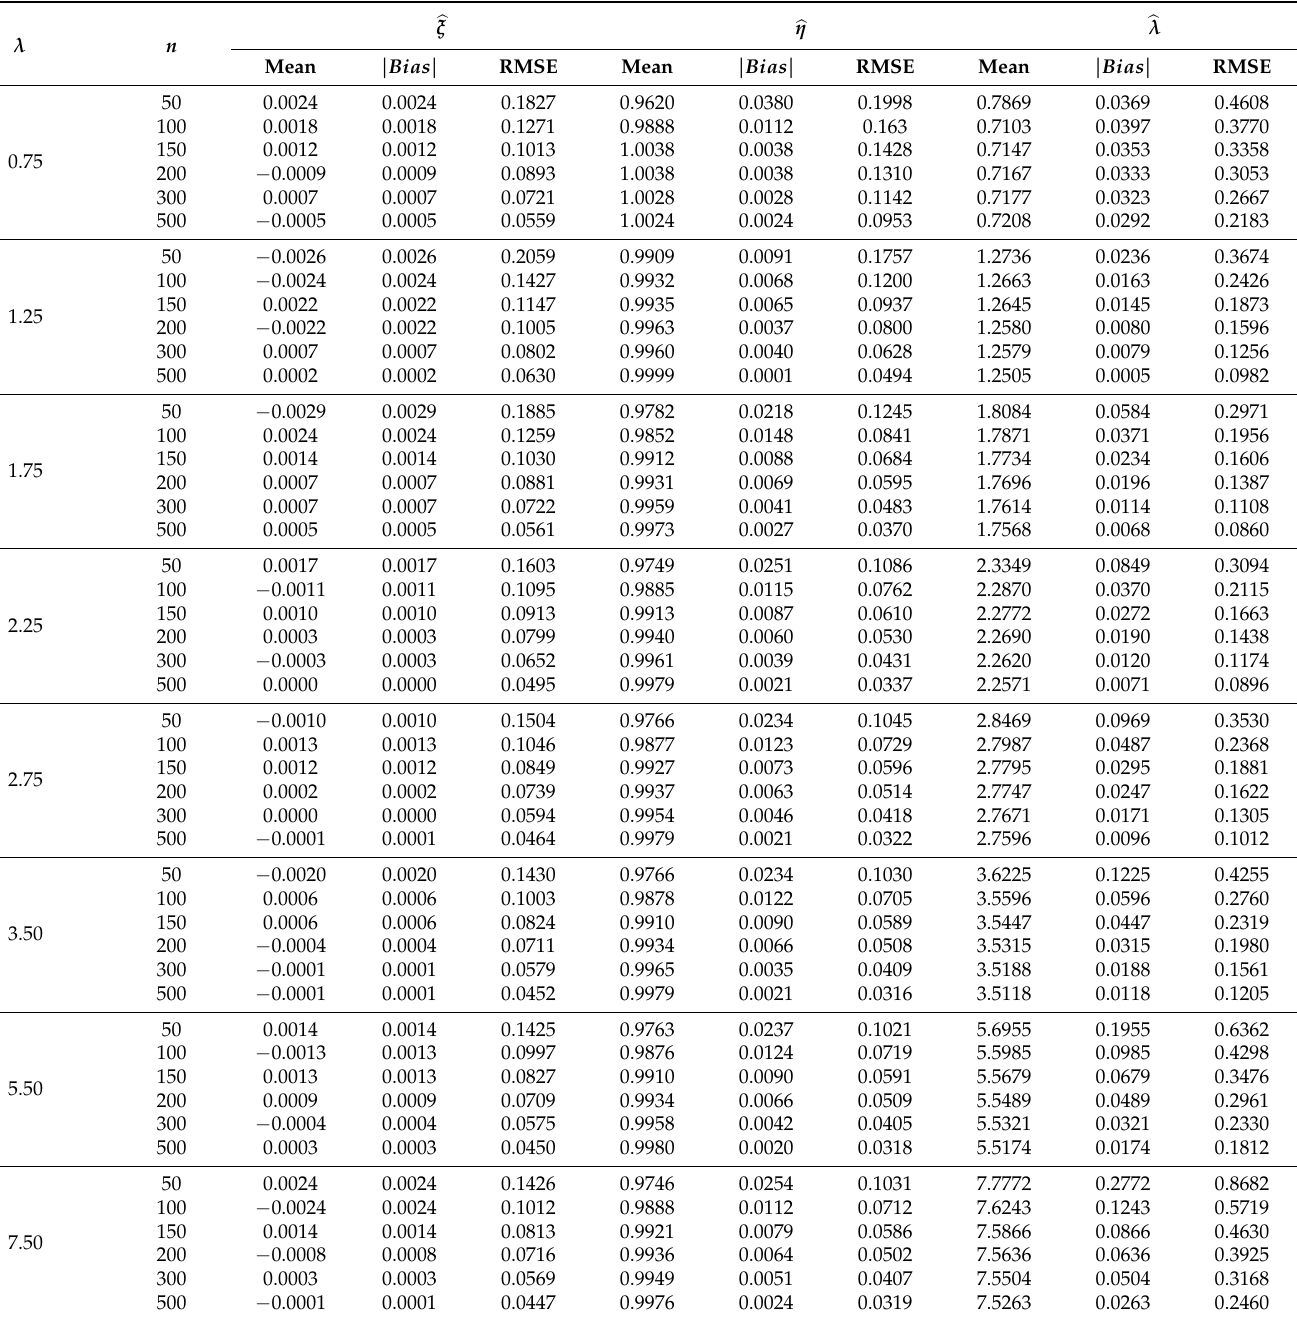
Table 2. Empirical mean, | Bias | , and RMSE for the TN